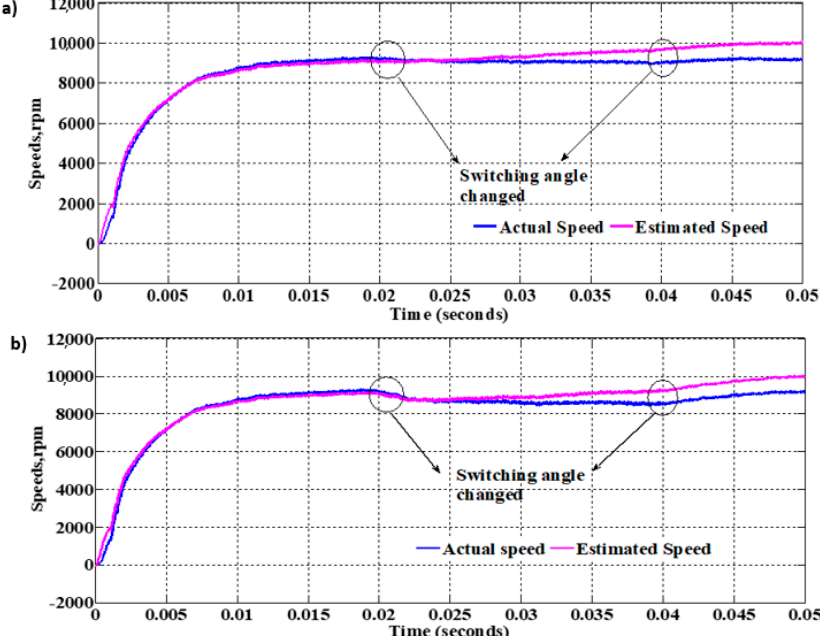
Figure 22. ( a ) Estimated and actual speeds when switching angle is changed to 11 degrees and ( b ) Estimated and actual speeds when switching angle is changed to 13 degrees.